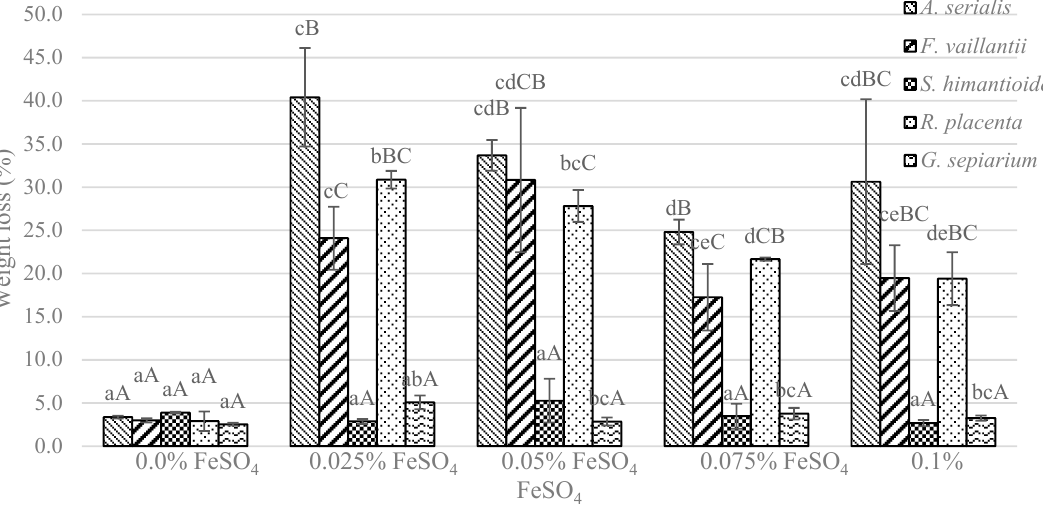
Figure 2. Weight losses by brown rot fungi in Scots pine wood blocks treated with different concentrations of FeSO 4 after 12 weeks incubation. Uppercase letters indicate significant differences between weight losses in impregnated wood specimens and the controls. Lowercase letters indicate significant differences between the studied brown rot fungi for each metal concentration. Data are represented as mean ± SD of three biological replicates ( p < 0.05).